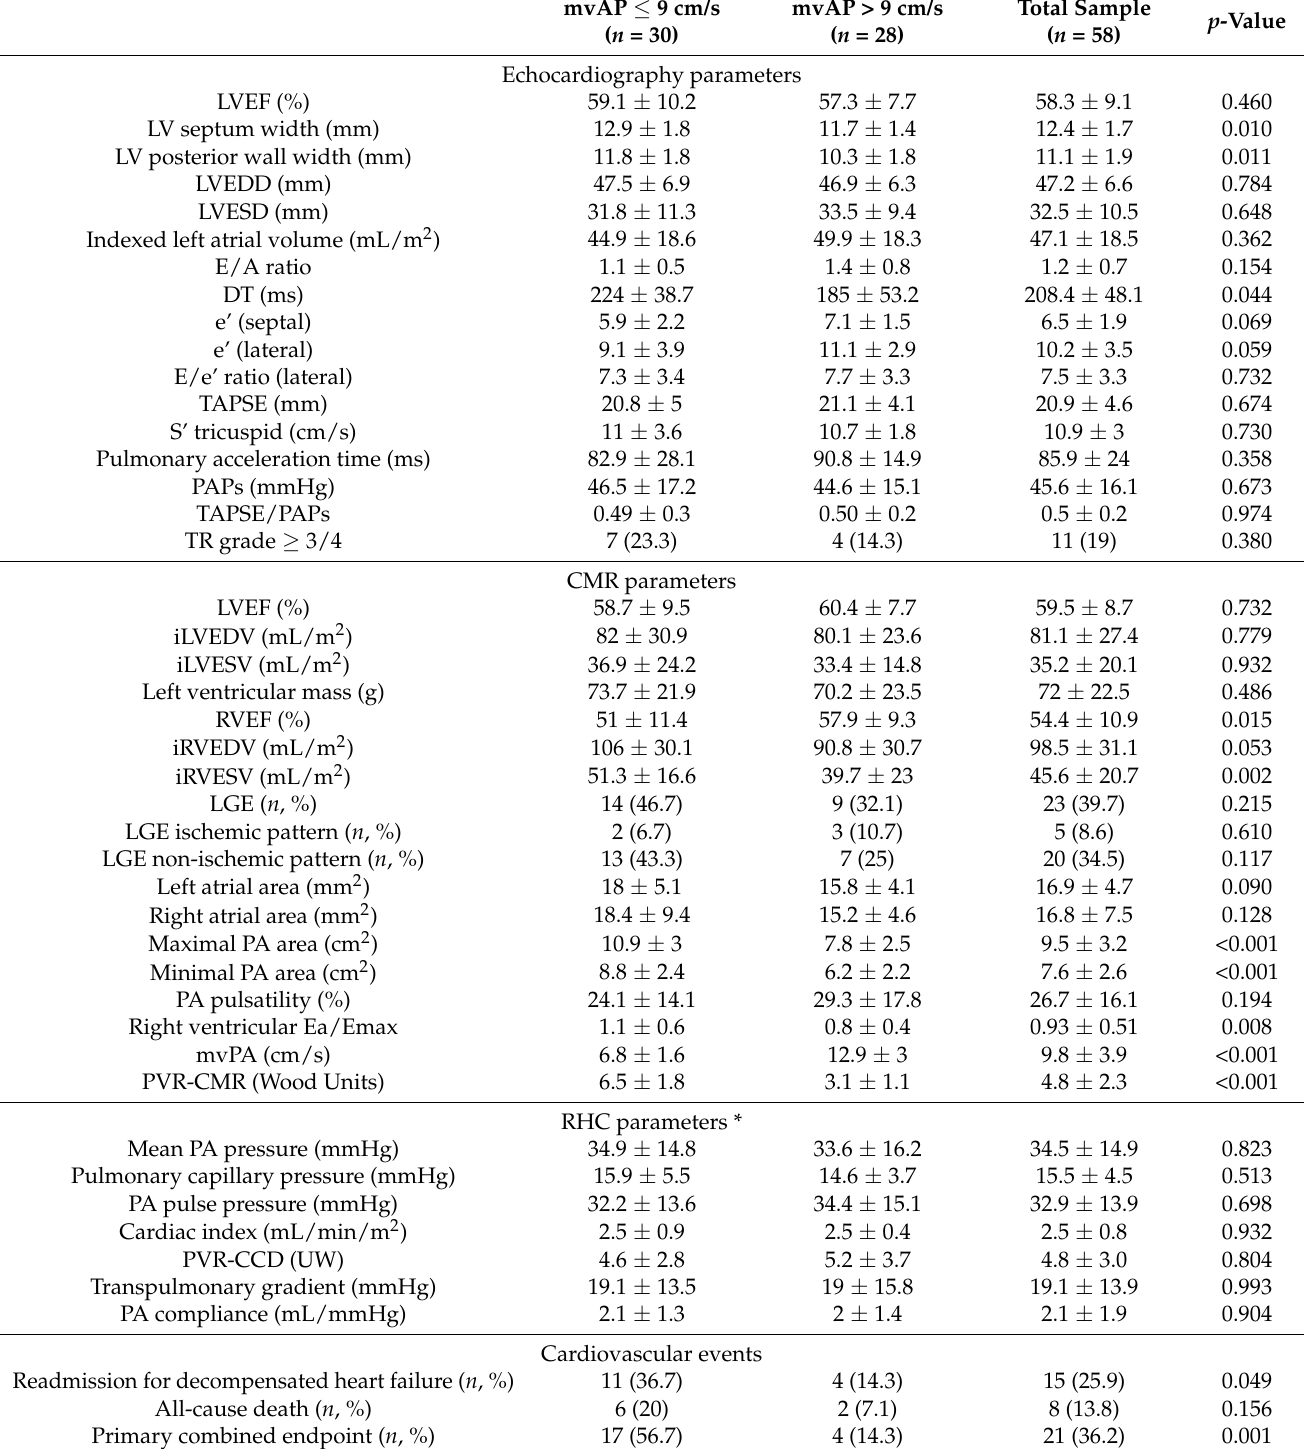
Table 3. Baseline imaging and invasive hemodynamic parameters according to